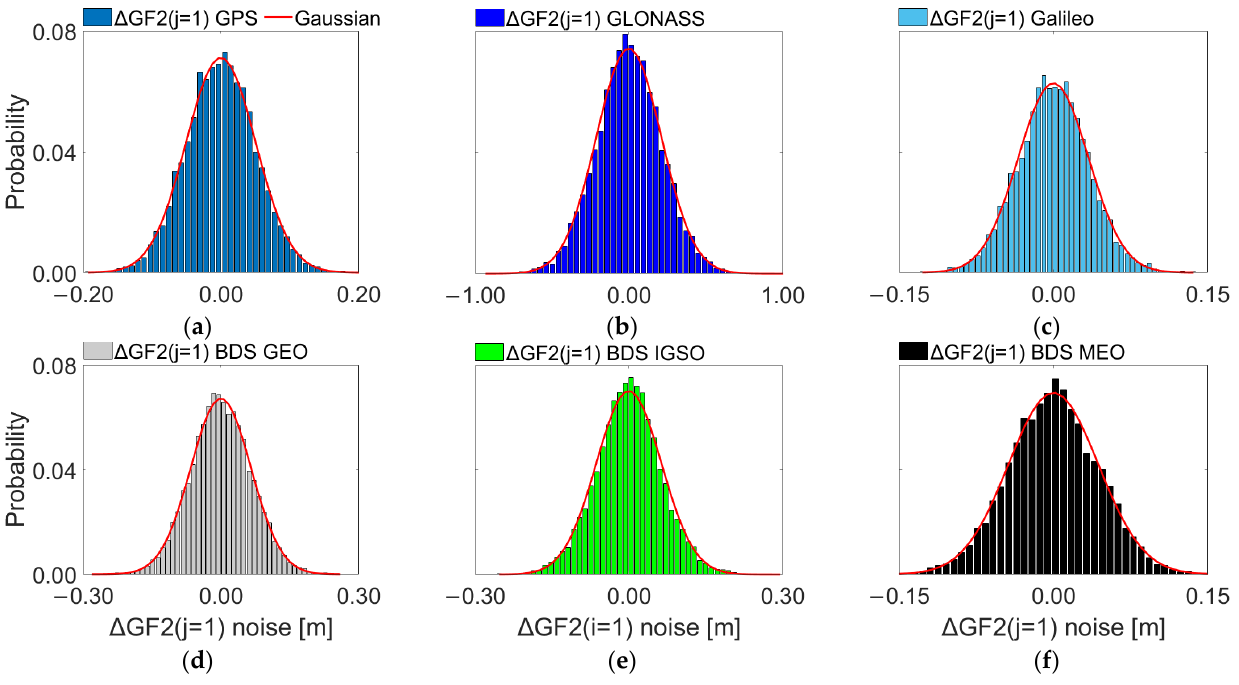
(cid:0) (cid:0) ∆ (cid:1)(cid:1) GF 2, k , r ,1 0,var of ( a ) GPS, ( b ) GLONASS, ( c ) Galileo, ( d ) BDS